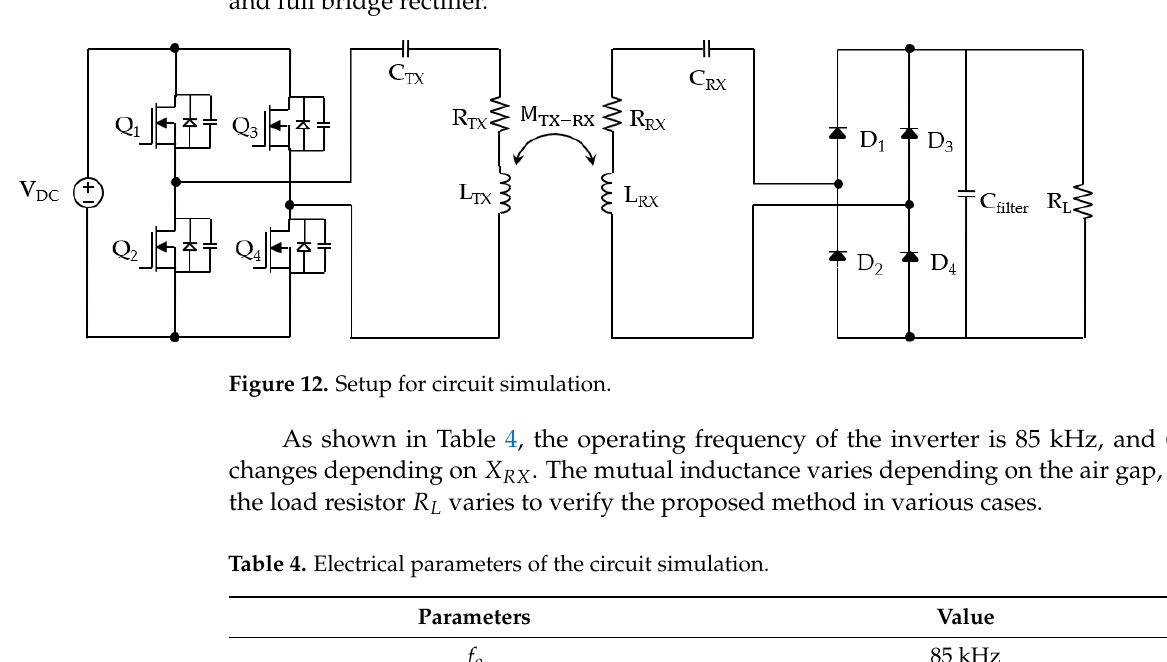
Figure 12, the WPT system is composed of the inverter, TX and RX coils, resonant capacitor, and full bridge rectifier.